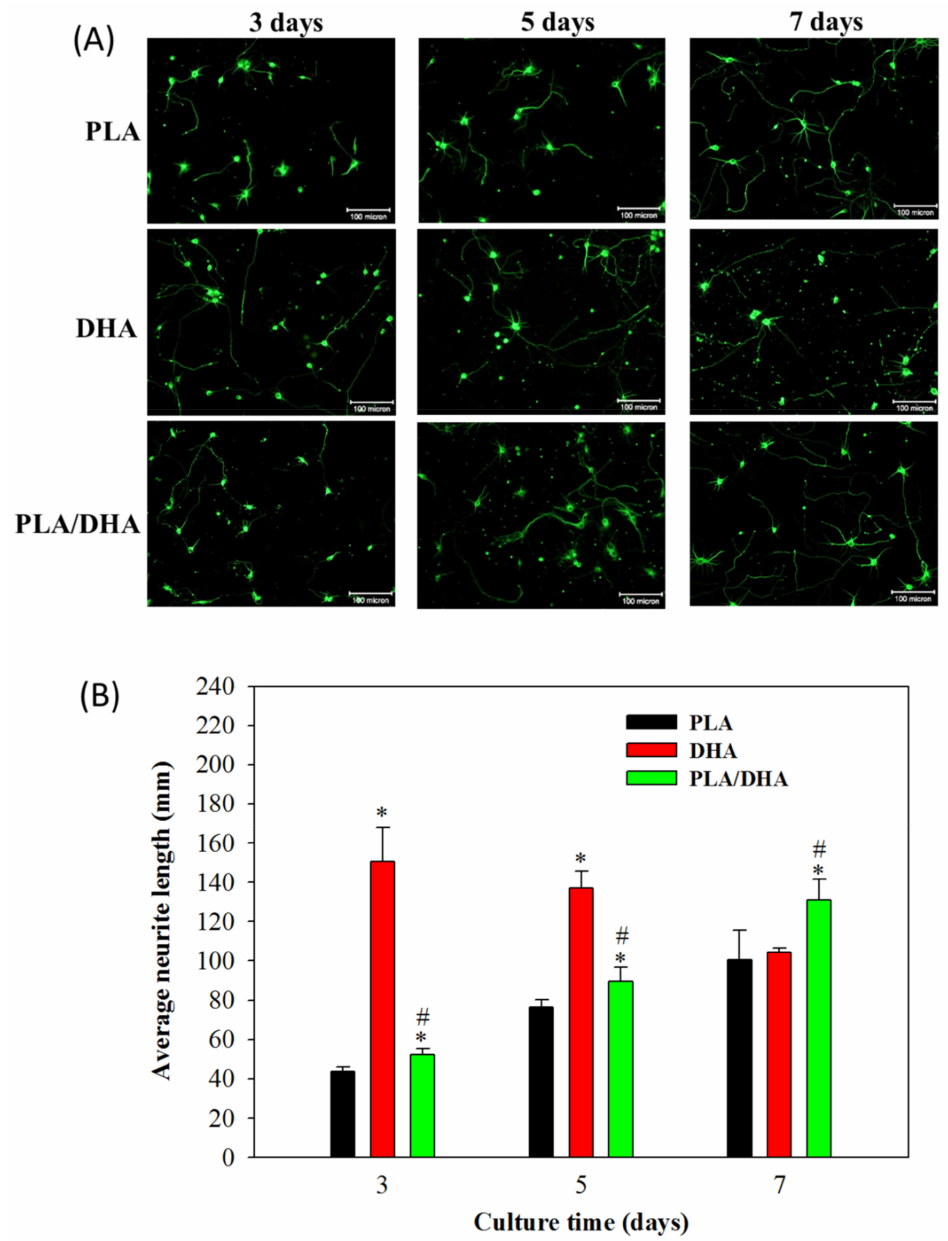
Figure 8. ( A ) The observation of neurite outgrowth from β -tubulin-III-positive primary cortical neuron cells after being co-cultured with polylactic acid (PLA) and polylactic acid / docosahexaenoic acid (PLA / DHA) core-shell nanofiber membrane in culture medium or cultured with 3 µ M DHA in culture medium for 3, 5, and 7 days (bar = 100 µ m). ( B ) The average neurite length due to neurite outgrowth was calculated for each neuron ( n = 3, mean ± SD). * p < 0.05 compared with control, # p < 0.05 compared with